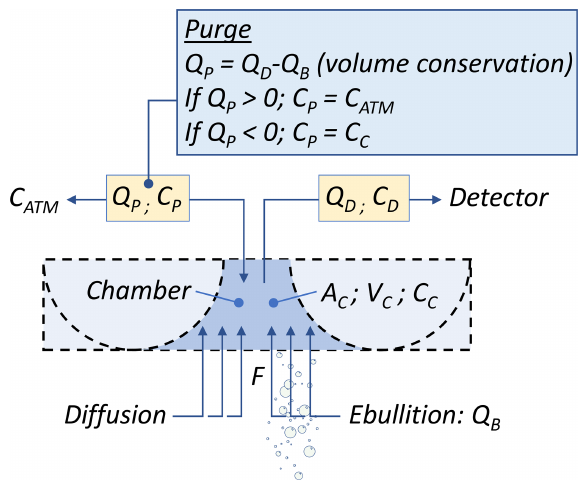
Figure 2. Mass balance of the MOD chamber (see text for